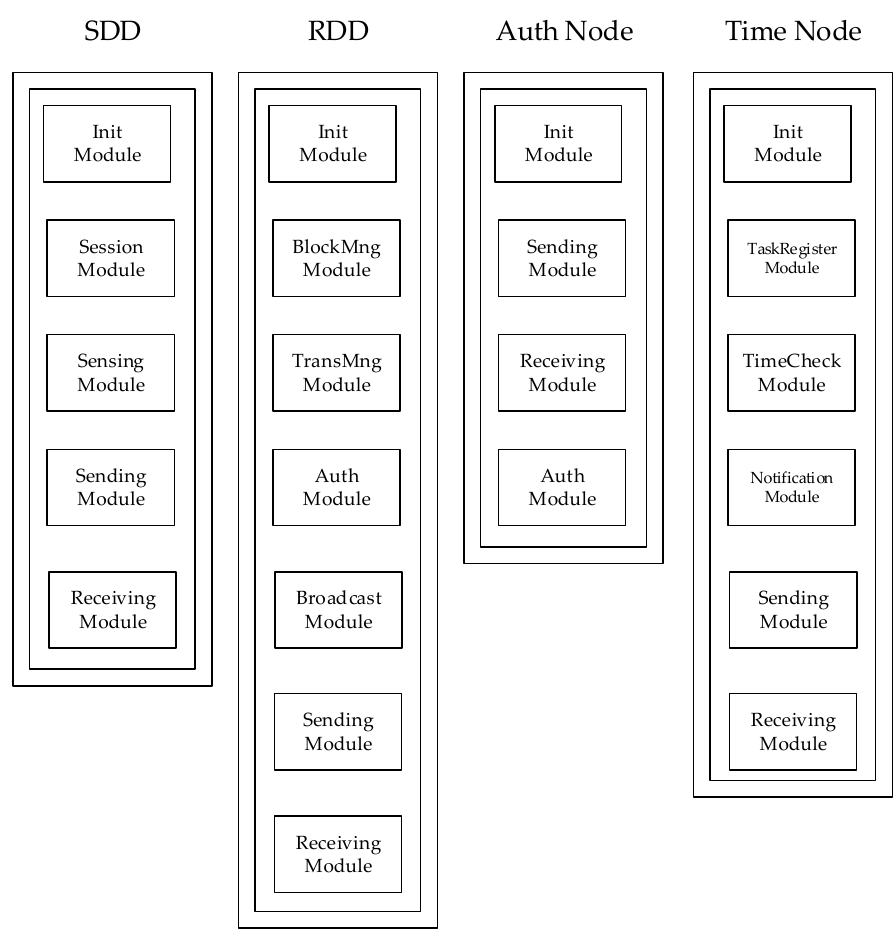
Figure 10. The software module configuration for the binary tree-structured lightweight blockchain.